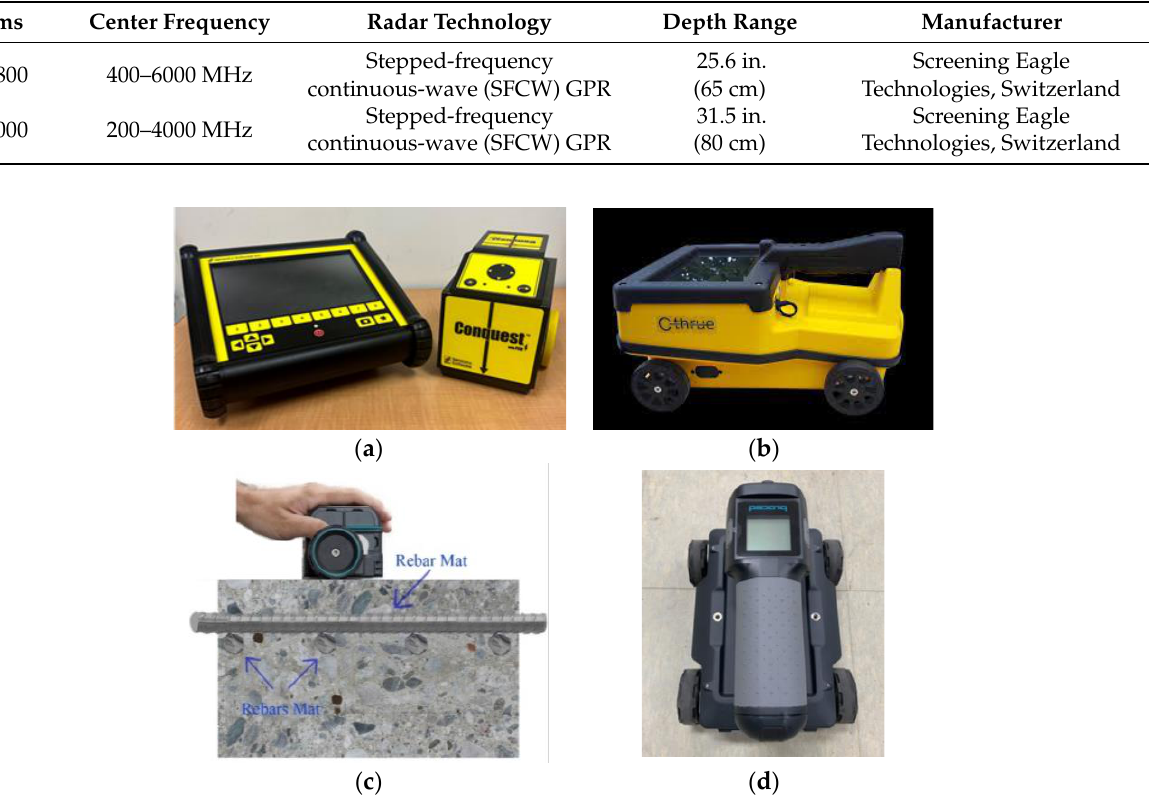
Figure 5. GPR systems used: ( a ) Conquest 100 Enhanced, ( b ) C-Thrue radar [105], ( c ) Proceq GP8800 [106], ( d ) Proceq GP8000 [107].